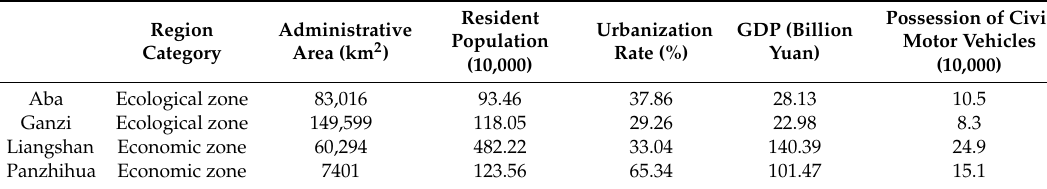
Table 1. Resident population, urbanization rate, population density, gross domestic product (GDP), possession of civil motor vehicles and area in the ecological and economic zones of Western Sichuan Plateau.